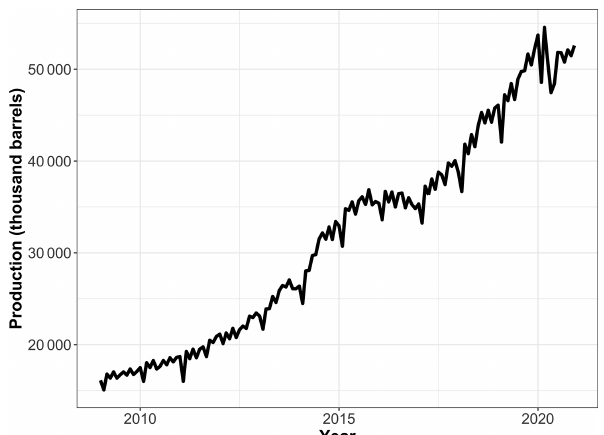
Figure 8. US field production of propane in thousands of barrels per month. Data courtesy of the U.S. Energy Information Admin- istration. The production plateaued from June 2014 to December